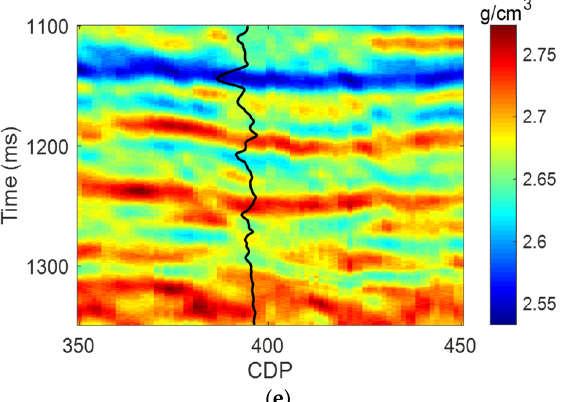
Figure 16. Final inversion pro fi les of ( a ) c 33 , ( b ) c 55 , ( c ) c 11 , ( d ) c 13 , and ( e ) ρ , by using Graebner’s exact formula and the adaptive FSA in the second step of the sequential method. The corresponding well logs are given. Table 4. Correlation coe ffi cients of the inversion results by seismic traces near the well in Figures 13 and 14 and the real logs.